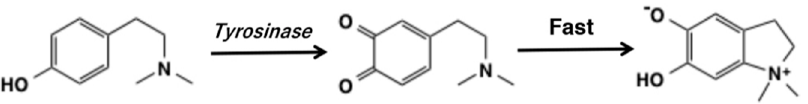
Figure 3. Tyrosinase-catalyzed oxidation of N , N -dimethyltyramine [11]. This reaction requires a catalytic amount of L-dopa. The o -quinone rapidly gives the indolium salt in a spontaneous reaction. This salt does not have an activity to activate met -tyrosinase and, thus, the oxidation stops at this stage.